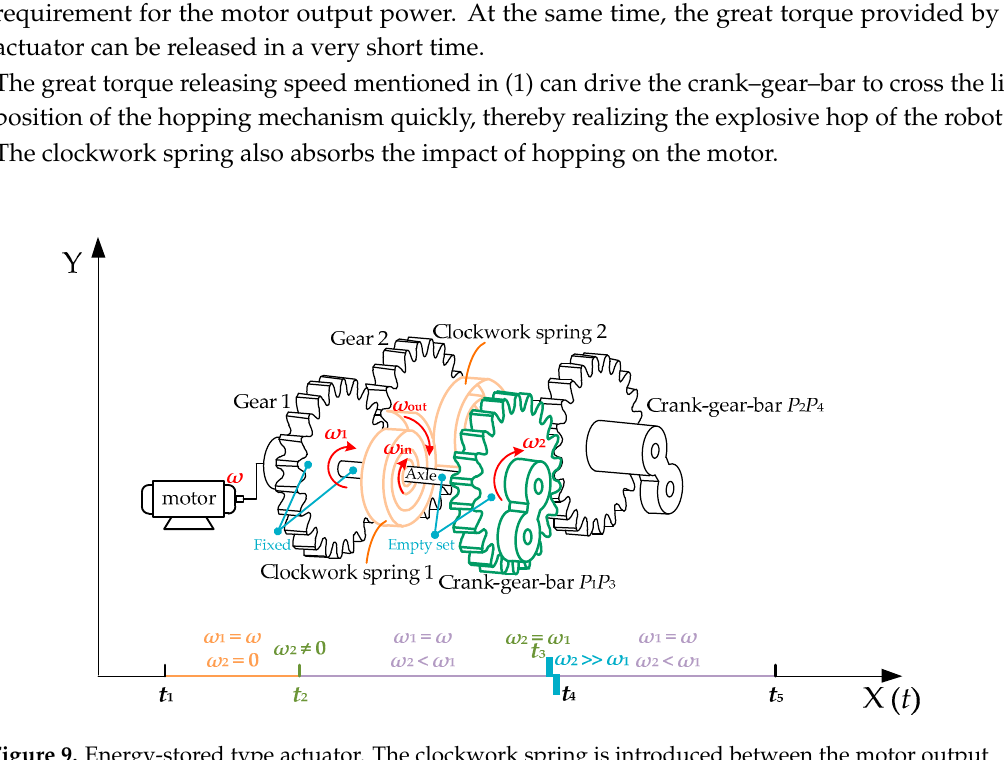
Figure 8. Hopping mechanism. ( a ) Optimization result. ( b ) Solid model.